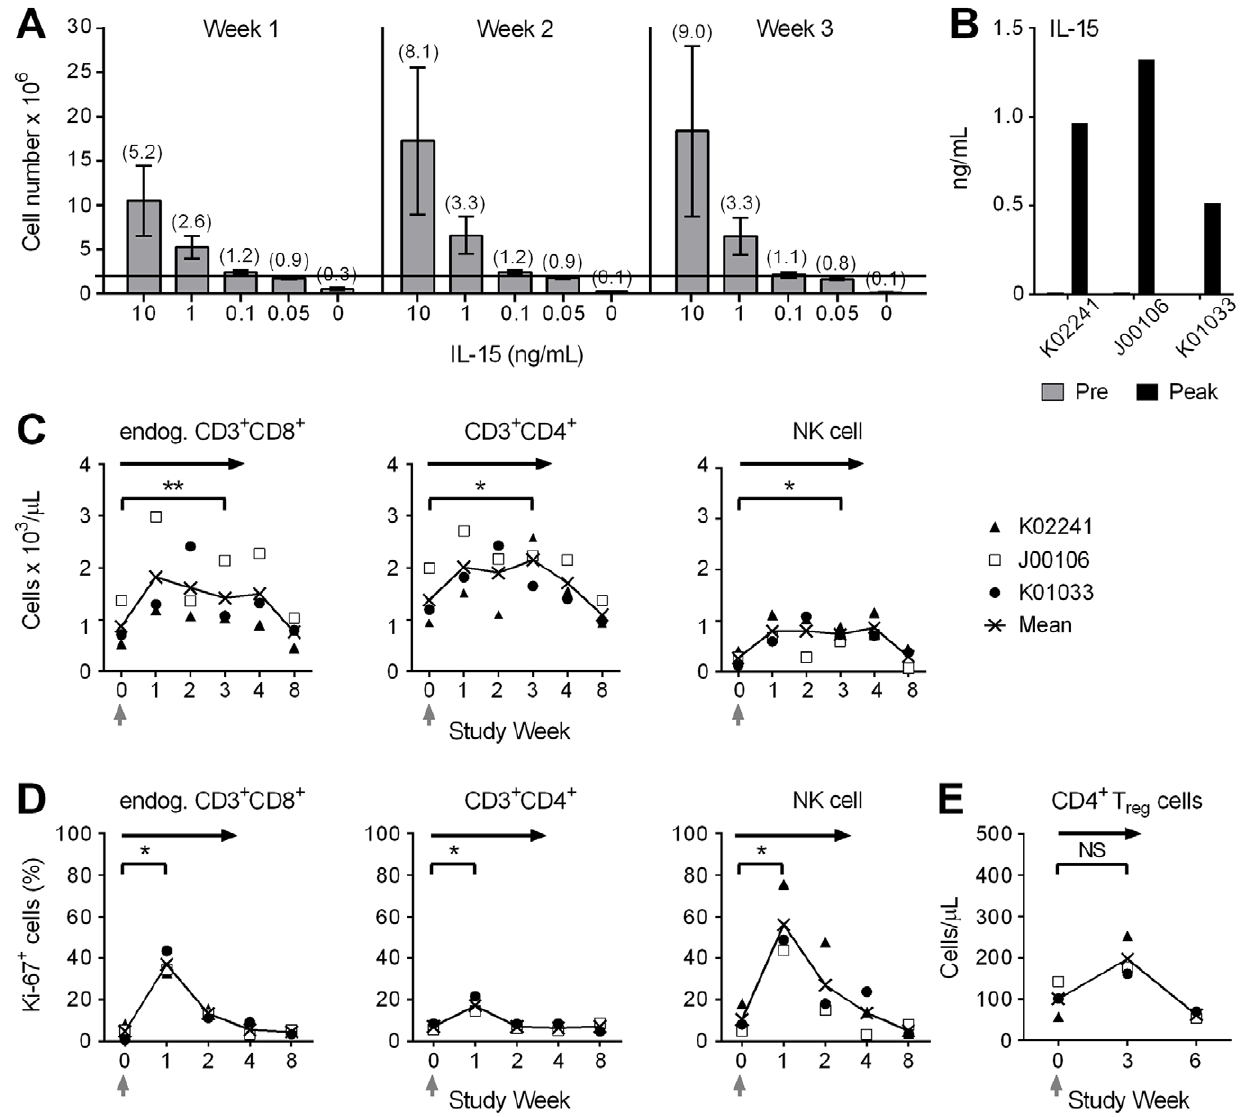
Figure 1. Effects of IL-15 on CD8 + T CM/E in vitro and endogenous cells in vivo. (A) In vitro survival of CMV-specific CD8 + T CM/E clones. T CM/E cells were stimulated for 14 days with anti-CD3/CD28 mAbs, c -irradiated feeder cells, and IL-2 (50 U/mL). Aliquots were washed and plated in media alone, or media containing 0.05 2 10 ng/mL of IL-15. Cell numbers of 6 T CM/E clones from different macaques were determined by counting viable cells at the indicated time points. Shown are mean 6 SEM, and the fold-increase compared to day 0 in parenthesis. (B) IL-15 levels. Samples of plasma obtained from macaque K02241, J00106, and K01033 prior to treatment (gray bars) and 2 hours after the third dose of IL-15 given on day 6 after the T cell infusion (black bars), were examined for IL-15. (C) Absolute numbers of endogenous D CD19 – CD3 + CD8 + and CD3 + CD4 + T cells, and CD16 + NK cells/ m L of peripheral blood of macaque K02241 (closed triangle), J00106 (open square), and K01033 (closed circle). PBMC were obtained before, during, and after the CD8 + T CM/E infusion with IL-15 and stained with mAbs to CD3, CD4, CD8, and CD16. (D) Intracellular Ki-67 expression. The percent (%) of Ki-67 + cells in endogenous D CD19 – CD3 + CD8 + or CD3 + CD4 + T cells, and CD16 + NK cells is shown for each of the 3 macaques. (E) Absolute numbers of CD4 + T reg cells/ m L in peripheral blood. PBMC were obtained at the indicated times from the macaques, stained with mAbs to CD3, CD4, CD25, and FoxP3, and examined by flow cytometry after gating on CD3 + CD4 + T cells. (C–E) The black line connects the mean ( 6 ) at each time point. The black arrows indicate the duration of the IL-15 treatment and the gray arrows indicate the T CM/E infusion. NS, not significant; * P , 0.05; ** P ,